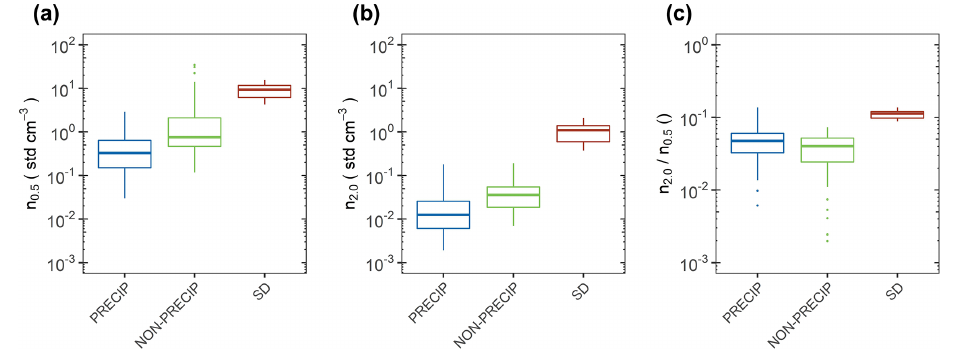
Figure 2. Number concentrations of aerosol particles with aerodynamic diameters (a) > 0.5µm [ n 0 . 5 ] and (b) > 2.0µm [ n 2 . 0 ] along with